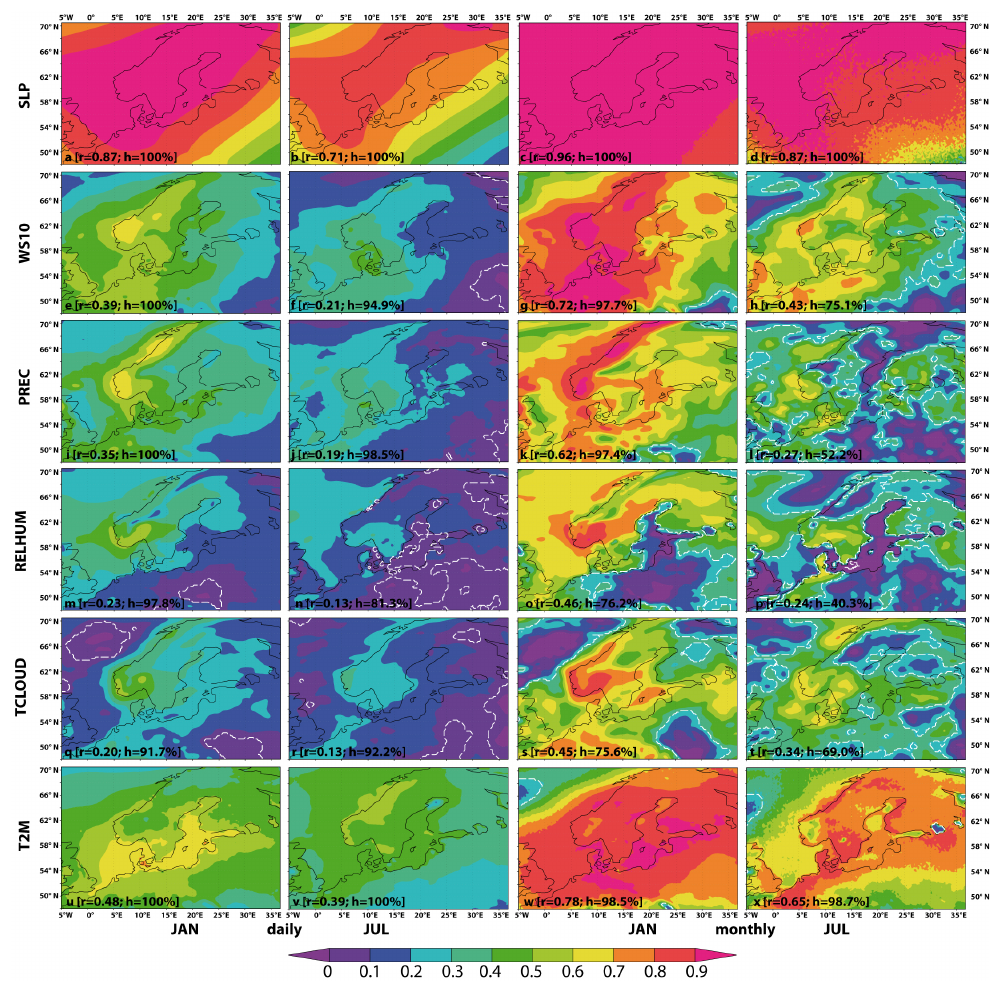
Fig. 6. Correlation maps on daily (left column) and monthly (right column) scale between HiResAFF and the reference fields of RCAO (RCAX for T2M) for January and July 1958–2007. White shaded lines indicate areas where h 0 of zero correlation cannot be rejected with p <